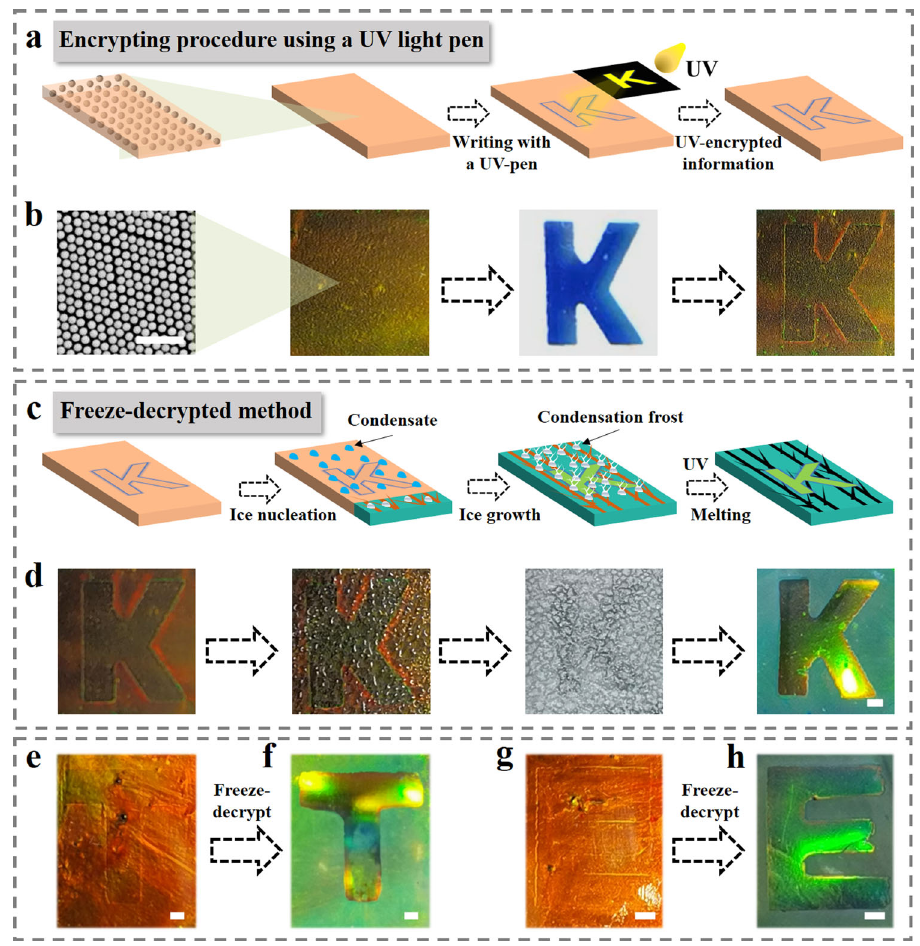
Fig. 7 A proof-of-concept demonstration of information encryption and decryption technology via icing wavelength blue shift. a, b Schematic illustration ( a ) and experimental images ( b ) of encryption process through UV light, in which an encrypted letter “ K ” was written onto the pregel fi lm using a UV light pen with the help of photomask. c , d Illustration ( c ) and optical images ( d ) of decryption process via freeze-photopolymerization. e – h Optical images of structural color hydrogel with letter information, including the UV-encrypted information ( e, g ) and the freeze-decrypted results ( f, h ). Scale bars are 1 μ m in ( b ), and 1 mm in ( d – h